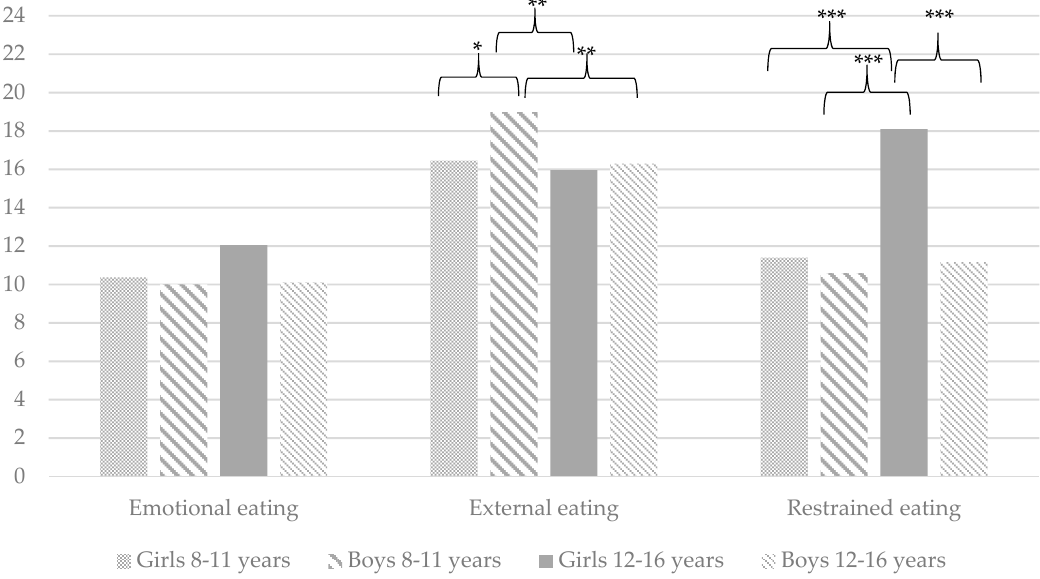
Figure 2. A child’s perspective: Mean problematic eating behaviours measured by the Dutch Eating Behaviour Questionnaire for Children(DEBQ-C). * p < 0.05, ** p < 0.01, *** p < 0.001. Only statistically significant differences are marked on the graph.